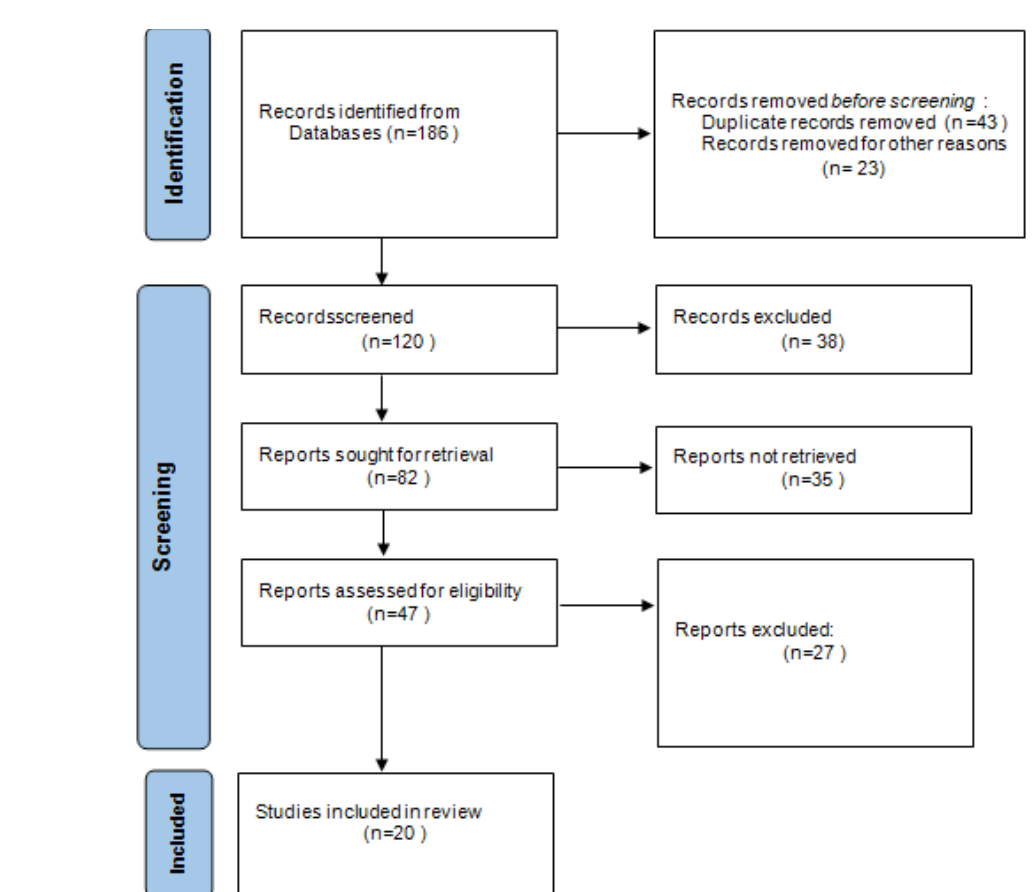
Figure 1. PRISMA flow diagram of the article selection process